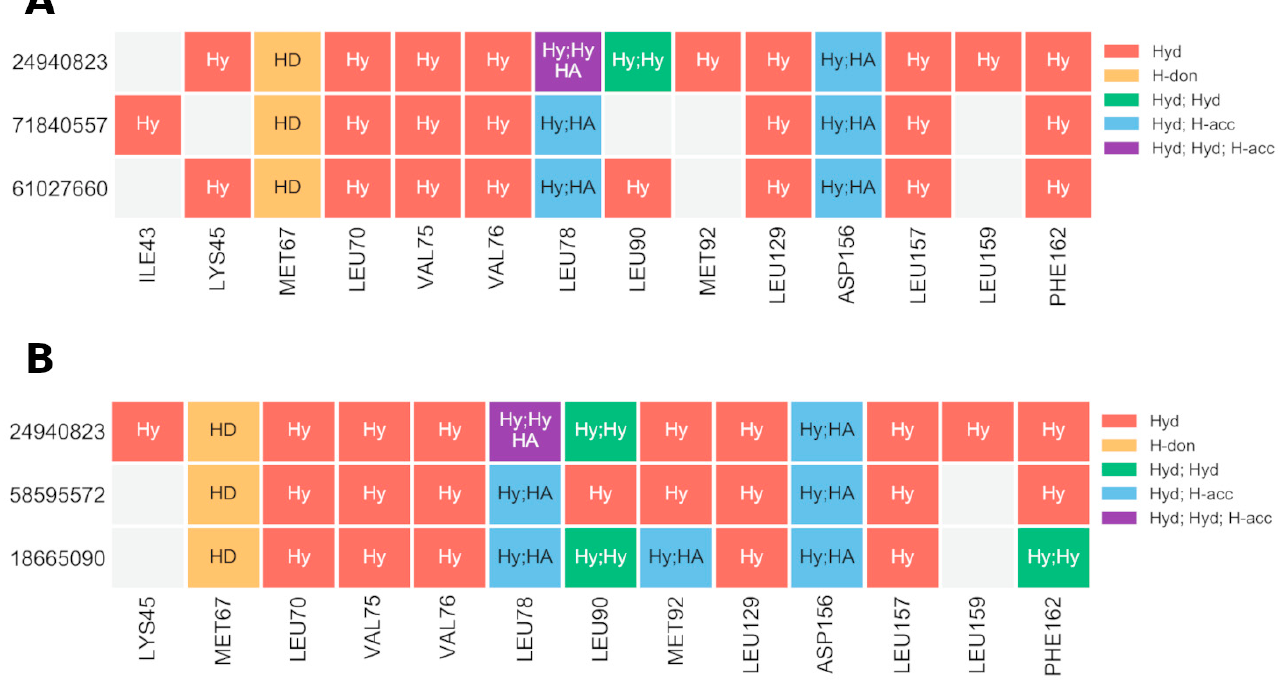
Figure 20. Protein–ligand interactions for the pairs in the SAR core #1 ( A ) and core #2 ( B ) involving the most active compound (24940823) in the RIPK1 inhibition assay. Hyd: hydrophobic contact, H- don: H-donor, H-acc: H-acceptor. ( C ) Docked poses of the compounds (71840557 in magenta and 61027660 in cyan) sharing the first core with 24940823 (in green). Only key differing contacts are proven to prevent the figure from becoming overly crowded with residues. Interestingly, comparing the binding pose of compound 24940823 with the co-crystal ligand of 5HX6 indicates that the former turns away from the entrance toward the ATP- binding site (see Supporting Figures S20 and Figure 2). 4. Conclusions Necroptosis inhibition has been intensely explored in the last decades to develop therapies for inflammatory and neurodegenerative diseases and acute ischemic injuries. RIPK1, a major biological player in the necroptotic cascade, is a very appealing target due to an unusual motif within its binding pocket that can be leveraged to produce inhibitors with excellent selectivity. Because of the attention given to this protein, there are now hundreds of compounds in the low micromolar and nanomolar range. However, unlike other kinases, no effort has yet been made to take advantage of these data to better under- stand RIPK1 inhibitors and to create general in silico predictive models that can be used to find new compounds. To bridge this gap, we propose here the first validated in silico